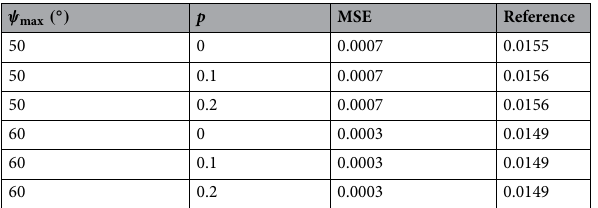
ψ max [ ◦ ] 1 Grain 2 Grains 3 Grains Mean